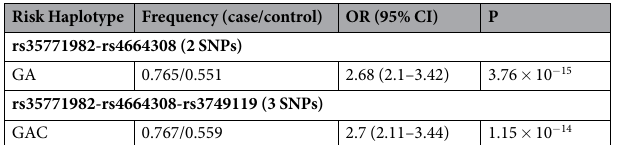
Risk Haplotype Frequency (case/control) OR (95% CI)